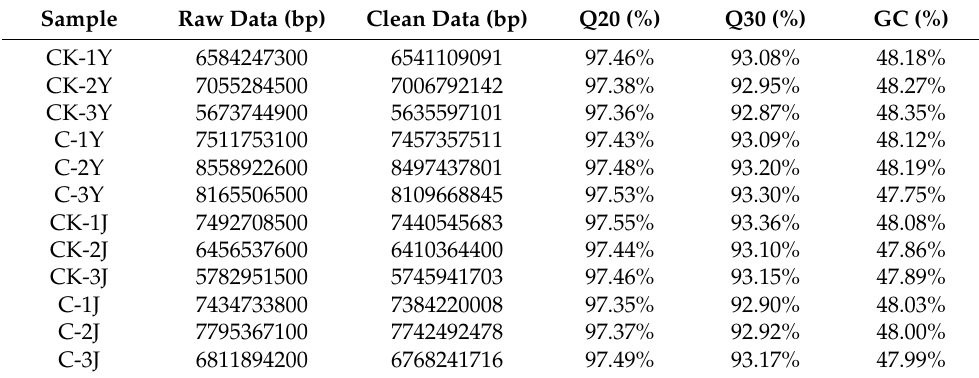
Table 1. Throughput and Quality Summary of the RNA